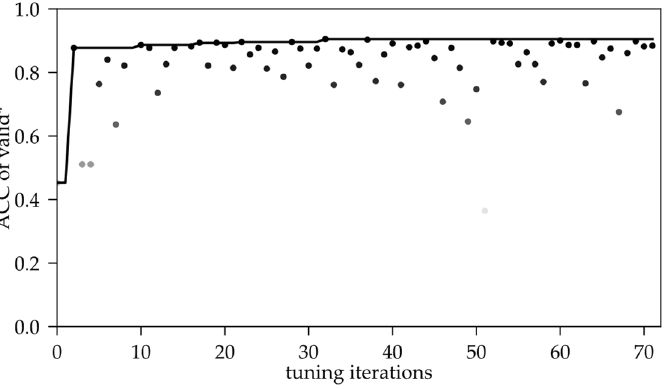
Figure 6. Accuracy and iterations of TPE optimization process.